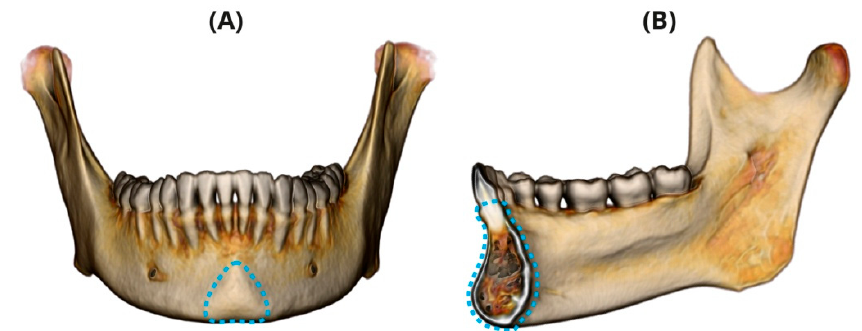
Figure 1. ( A ) Chin (mentum osseum). Frontal view of the mandible (using the volume rendering technique); chin borders (mental protuberance and bilateral mental tubercles) are denoted by a dotted line. ( B ) Mandibular symphysis. Midsagittal section; symphysis borders are denoted by dotted lines.